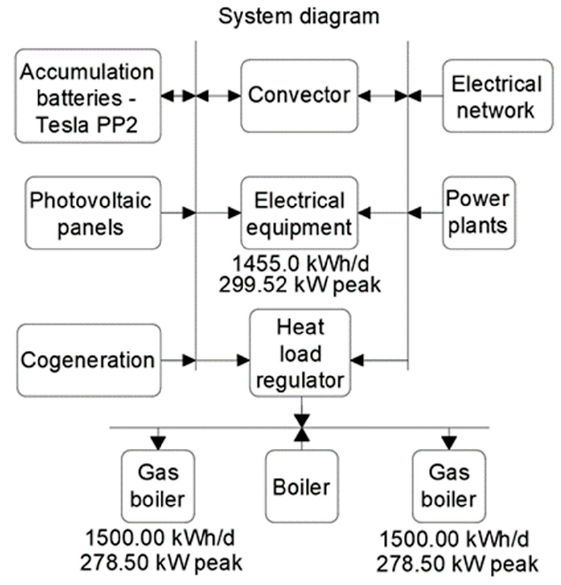
Figure 7. RES Microgrid